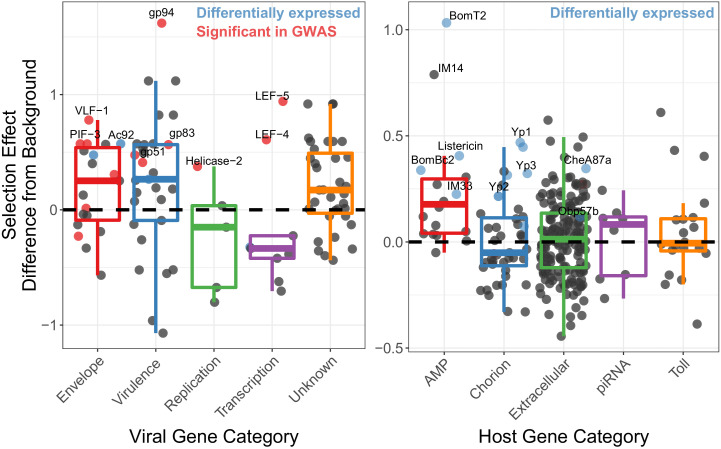
Genes implicated in host/virus interaction are rapidly evolving by positive selection in the Chiricahua population.Difference in selection effect for viral and host gene categories of interest from nearby background genes (average shown as 0, the dashed line), as indicated by the proportion of substitutions fixed by adaptation, weighted by mutations in SnIPRE (Eilertson et al., 2012). Genes that have associated SNPs from the association study are highlighted in red, while genes which are differentially expressed upon infection, or between viral types are labelled in blue. All association study hits are also differentially expressed and labelled in red. Genes of interest are named.